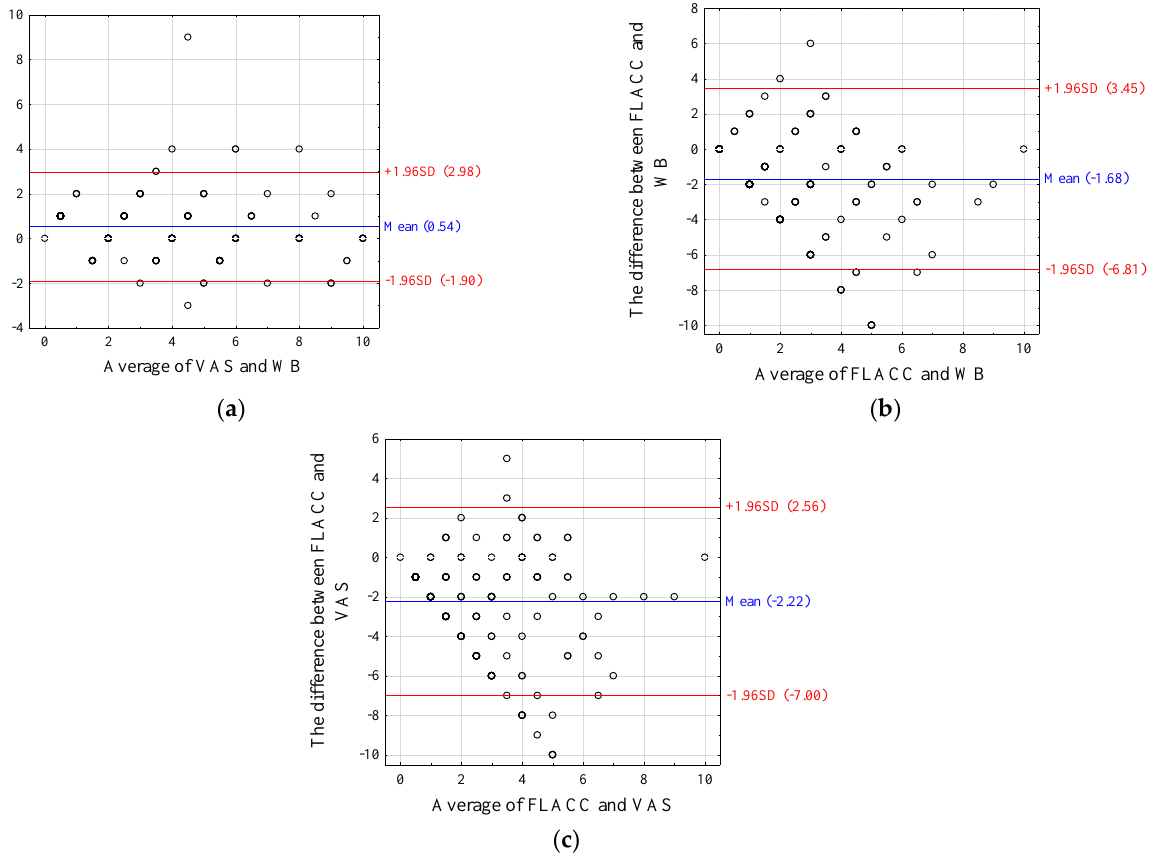
Figure 2. Bland – Altman charts comparing pain levels as assessed by WB, VAS, and FLACC. Figure 2. Bland–Altman charts comparing pain levels as assessed by WB, VAS, and